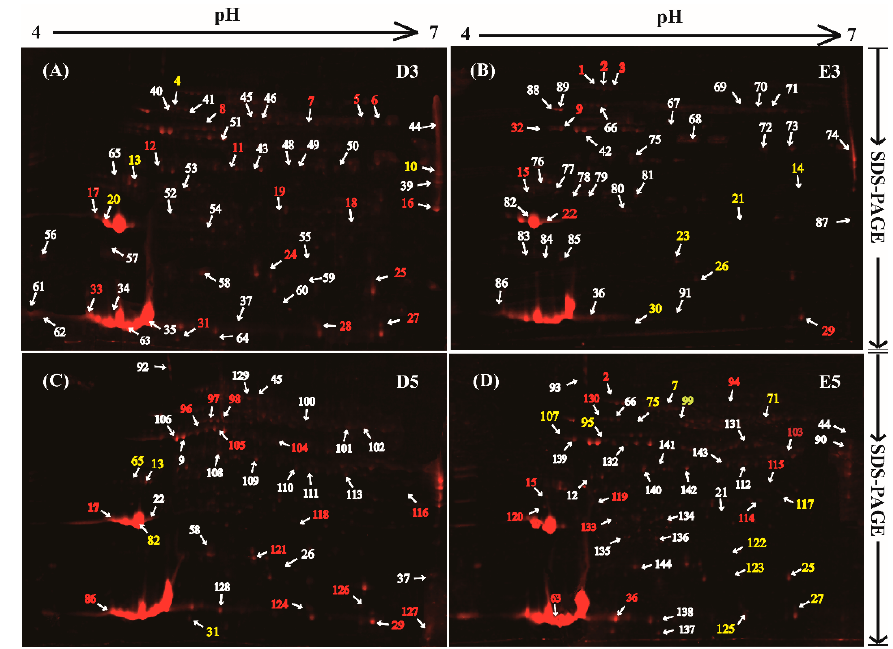
Figure 2. Reference proteome profiles of the glycosylated proteins in 2-DE gels and MS identification of differentially accumulated glycoproteins after ethylene treatments. The glycosylated proteins in total rubber latex from the rubber tree treated with water ( A , C ) and ethylene ( B , D ) for three (D3, E3) and five days (D5, E5) were dyed with Pro-Q Emerald 488 in the 2-DE gels and the protein spots were visualized by a typhoon scanner. The main protein spots were incised, and 144 protein spots were positively identified by MS. The ethylene-induced protein spots are marked with red numbers, and reduced spots are yellow numbers. The white numbers stand for the unchanged protein spots upon stimulation. These typical 2-DE gels were selected from the three biological replicates. Both protein accumulation levels and the fold change patterns are the average value from the three replicates. The glycosylated protein identities are presented in Table S1 and Figure S1.